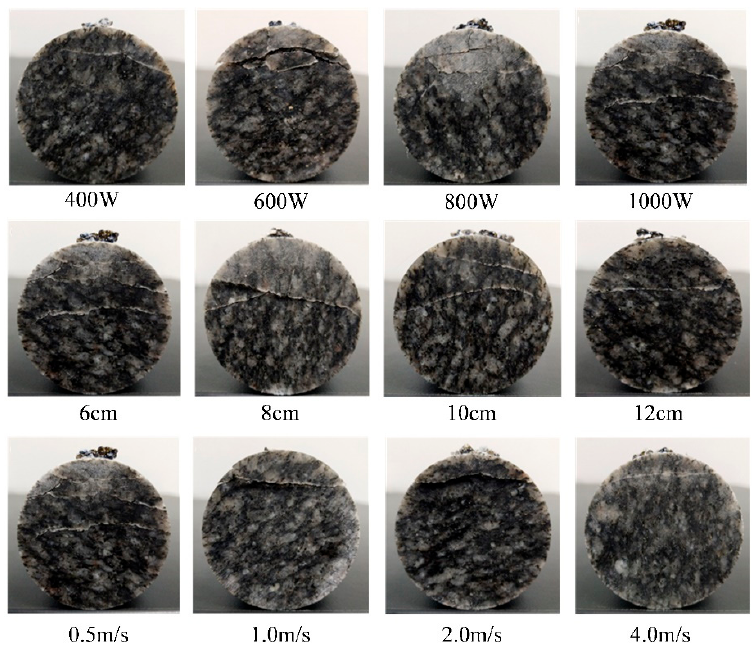
Figure 9. Cracks of irradiated granite on the bottom surface.